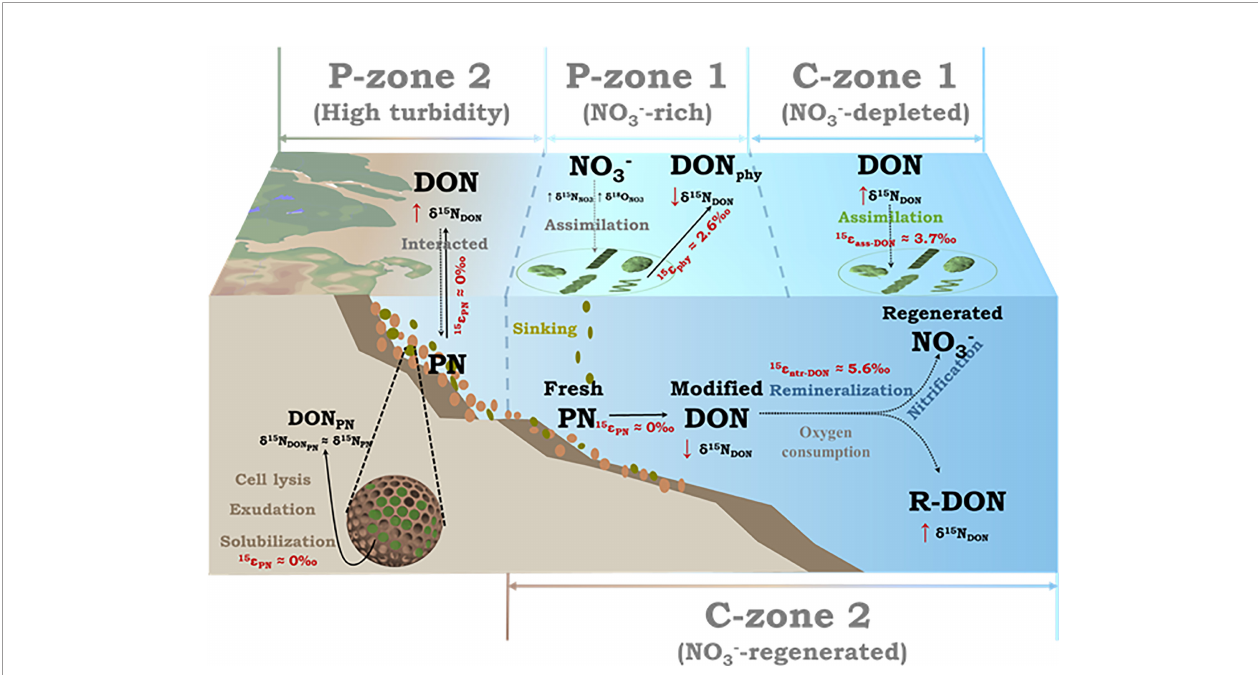
FIGURE 8 | Diagram of dissolved organic nitrogen production and consumption in the Changjiang Estuary and the adjacent East China Sea shelf areas with a description of the reaction pathways. The dotted arrow represents the consumption process, and the solid arrow represents the production